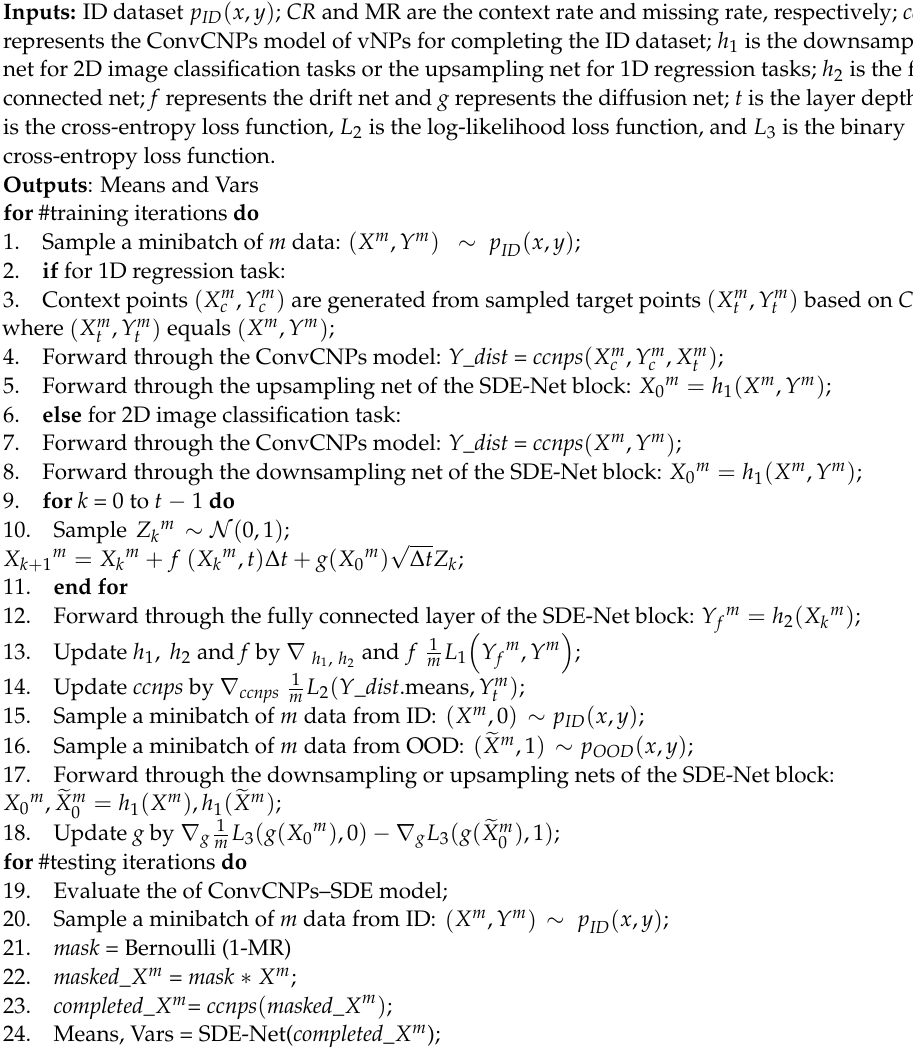
Algorithm 1 Implementation of the ConvCNPs–SDE